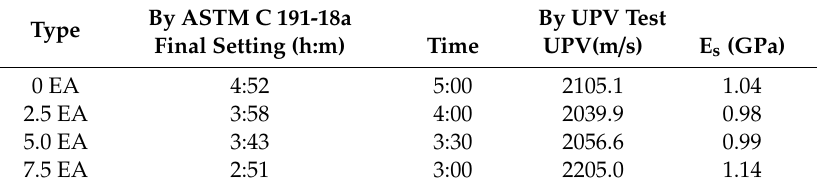
Table 6. UPV and dynamic modulus of elasticity at the final setting time of the AAM mortar.